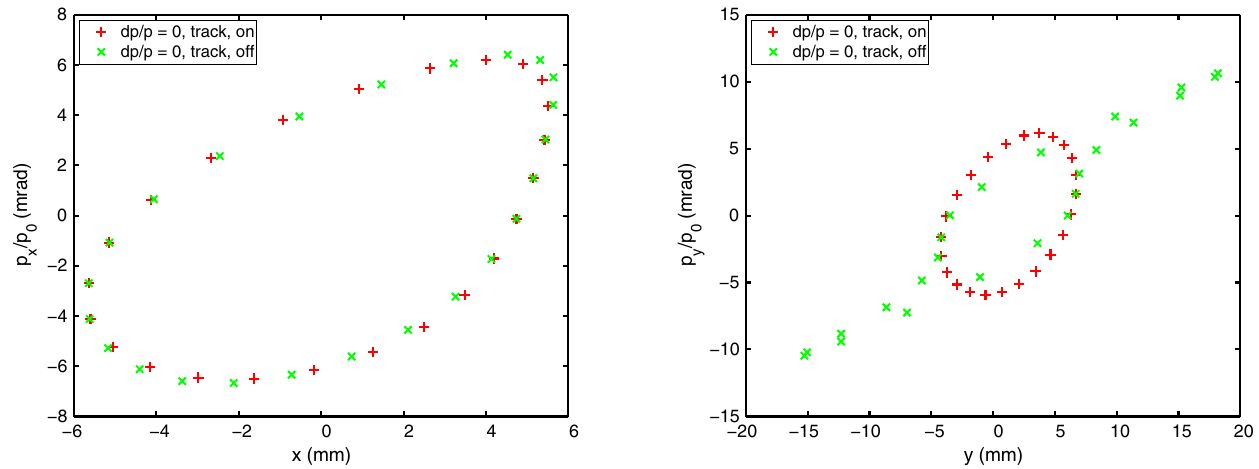
FIG. 14. Final in-plane (left) and out-of-plane (right) phase space at the isocenter. The importance of the three octupole corrections in the out-of-plane phase space is very dramatic. Note the scale of the plots is not the